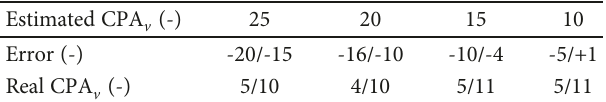
Table 6: Vertical CPA estimation